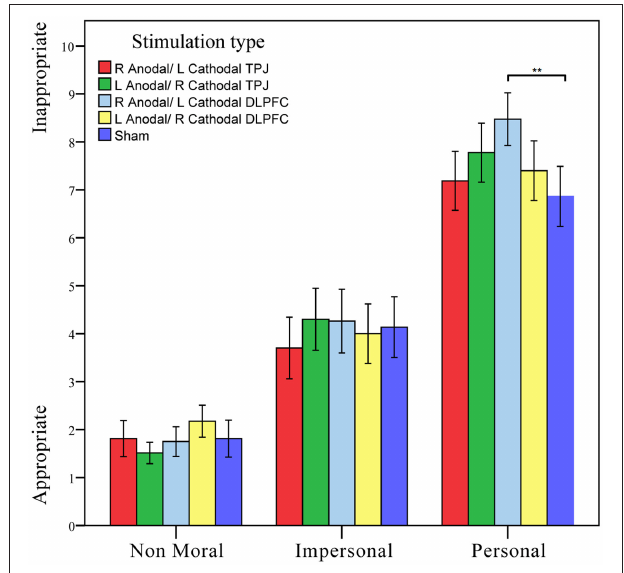
FIGURE 3 | Data of moral response ratings. The moral response ratings of participants with moral-personal, moral-impersonal and non-moral conditions across stimulations. Error bars indicate 95% confidence intervals. Asterisks indicate statistical significance of difference between treatments.